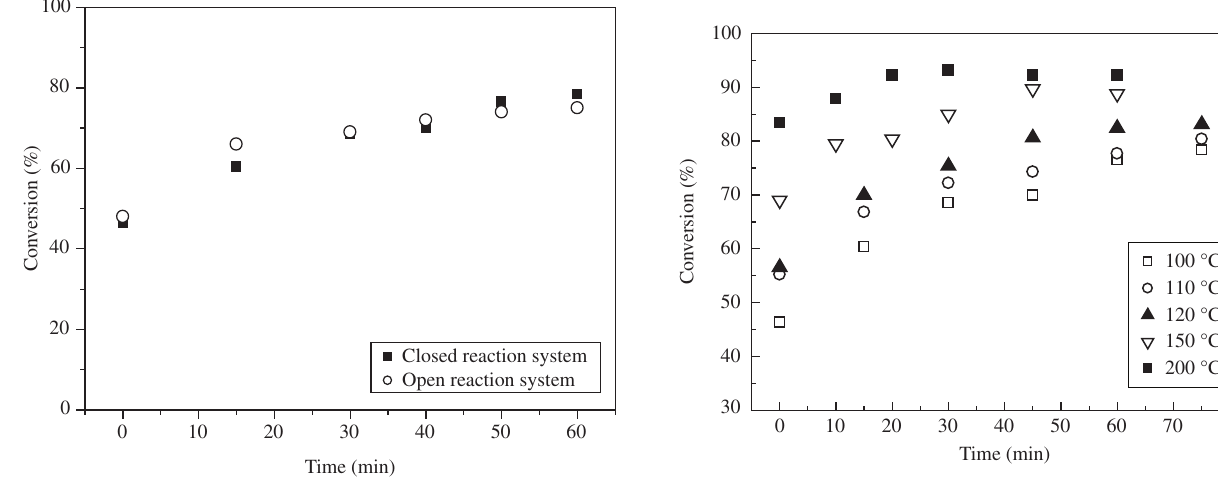
Figure 4. Silica conversion as function of reaction time, for the two types of systems: open and closed (T = 100 °C, H ratio = 2).